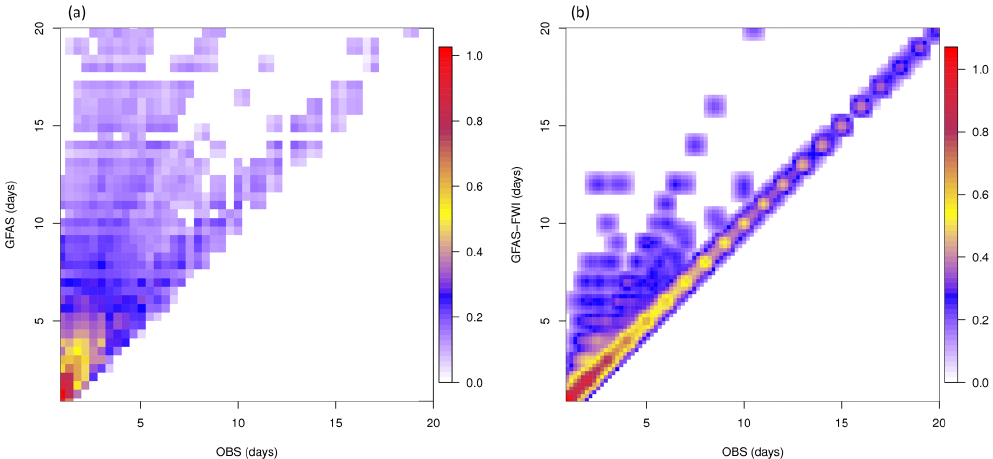
Figure 1. (a) Normalized density plot of average consecutive days of continuous fire observations as recorded by MODIS on board Aqua and Terra satellites versus the estimated values from the GFAS. The longer fire duration in the GFAS is due to the persistence assumption, which extends observations during observation blackout periods. (b) As before but for the application of the new FWI-based model.